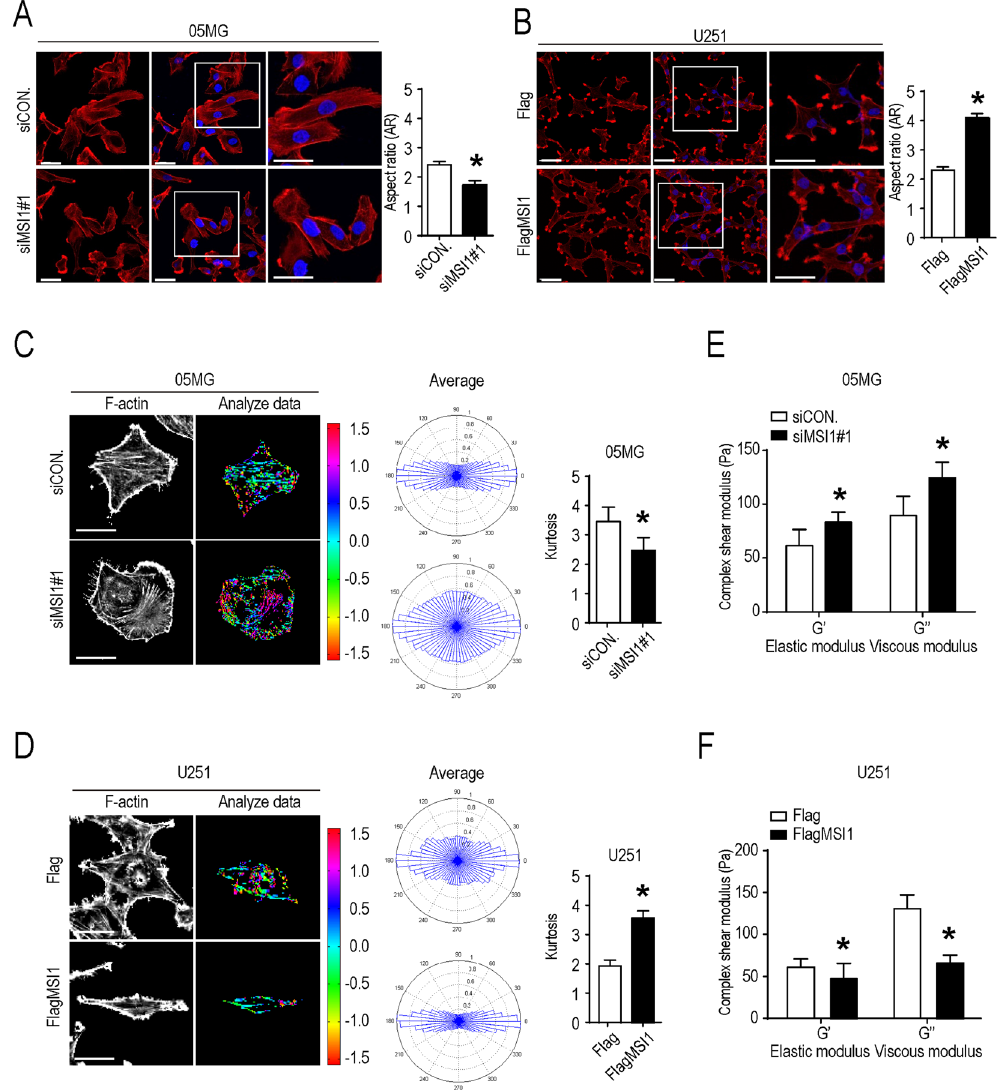
Figure 2. MSI1 increased the aspect ratio and decreased viscoelasticity of GBM cells. ( A )( B ) MSI1-depleted 05MG cells and MSI1-overexpressed U251 cells were immune-stained for F-actin (Red) and DAPI (Blue) and observed by fluorescent microscopy. The ratio of mean aspect (defined as the ratio of the length of major and minor axes, AR) were shown in the right (n = 100). ( C )( D ) Fluorescent color maps of F-actin networks distribution in MSI1-depleted 05MG cells and MSI1-overexpressed U251 cells. The formation and the angular distribution of F-actin orientation in MSI1-depleted 05MG and MSI1-overexpressed U251 cells were analyzed by assessing and quantifying the immunofluorescence intensities using MatLab software. The mean of Kurtosis from 45 cells was shown in the right. ( E ) ( F ) The intracellular elastic modulus ( G ’) and viscous modulus ( G ”, at 10 Hz) of MSI1-depleted 05MG and MSI1-overexpressed U251 cells were shown as mean ± SEM (n = 100 beads/ 35cells). Each bar chart is presented as mean ± SEM. The experiments were repeated at least three times. The statistical significance was assessed by one-way ANOVA, * P < 0.05 (relative to the control